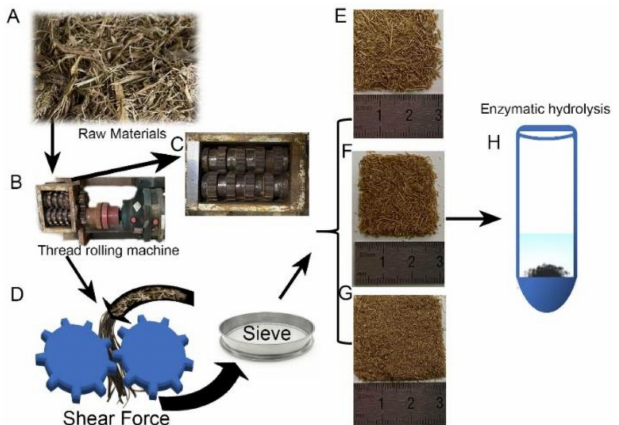
Figure 1. Mechanism of the thread rolling pretreatment (( A ) Corn stalks and sugar cane bagasse raw material; ( B , C ) Thread rolling mechine; ( D ) Schematic diagram of the mechanism of thread rolling; ( E ) 20–40 mesh sample; ( F ) 40–60 mesh sample; ( G ) 60–80 mesh sample; ( H ) Enzymatic hydrolysis reactor).